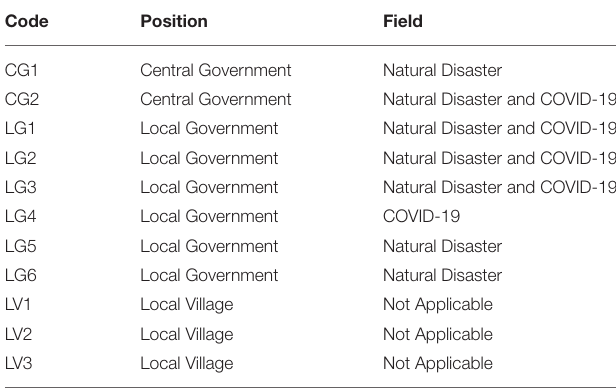
TABLE 1 | Backgrounds of